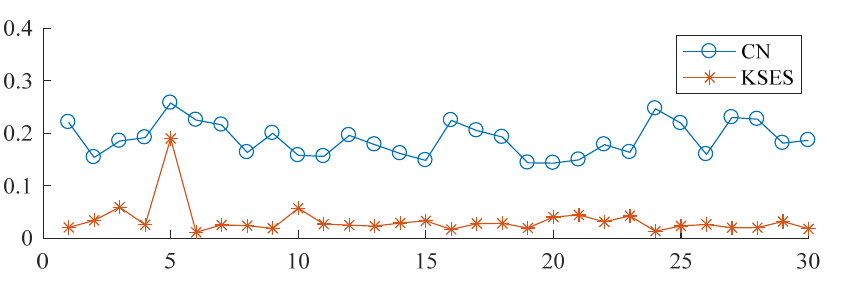
Figure 6. CN and KSES values of each component.